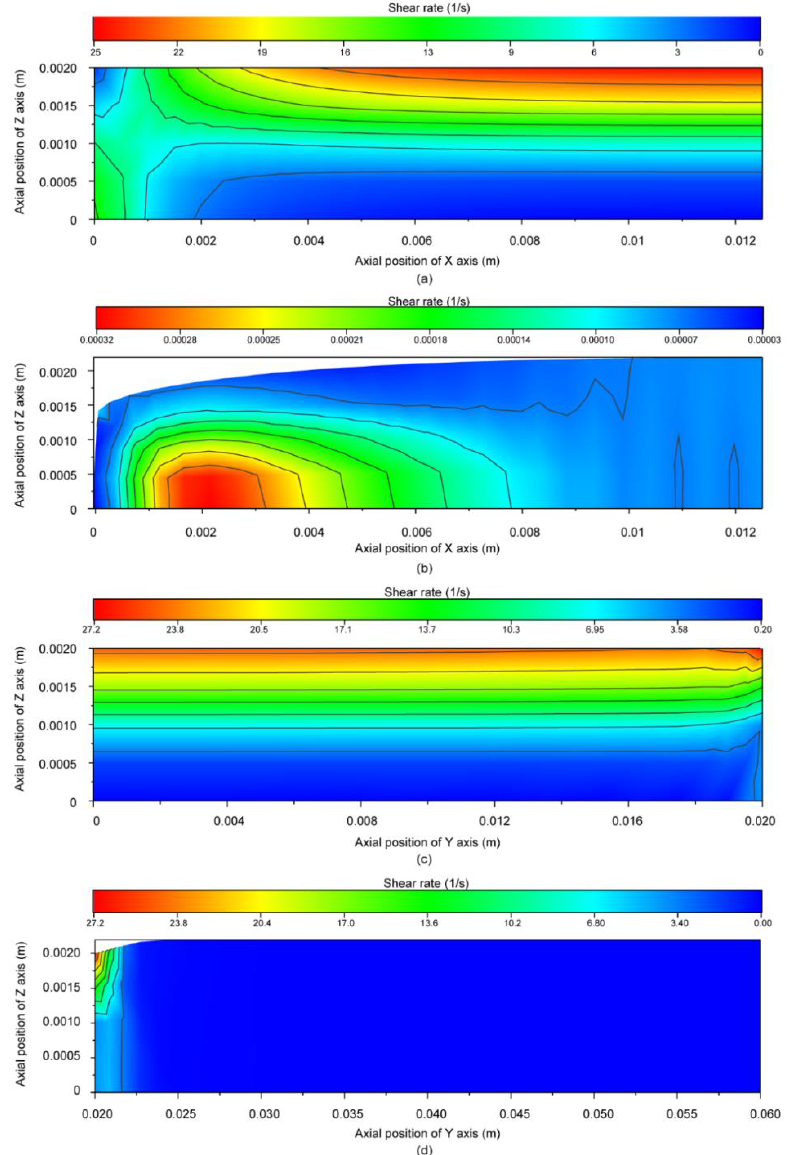
Figure 5. The shear rate field distribution using the WPC with 40% wood fiber as an example. Distribution of shear rate at: ( a ) the inlet; ( b ) the outlet; ( c ) on the plane of symmetry 1; ( d ) on the plane of symmetry